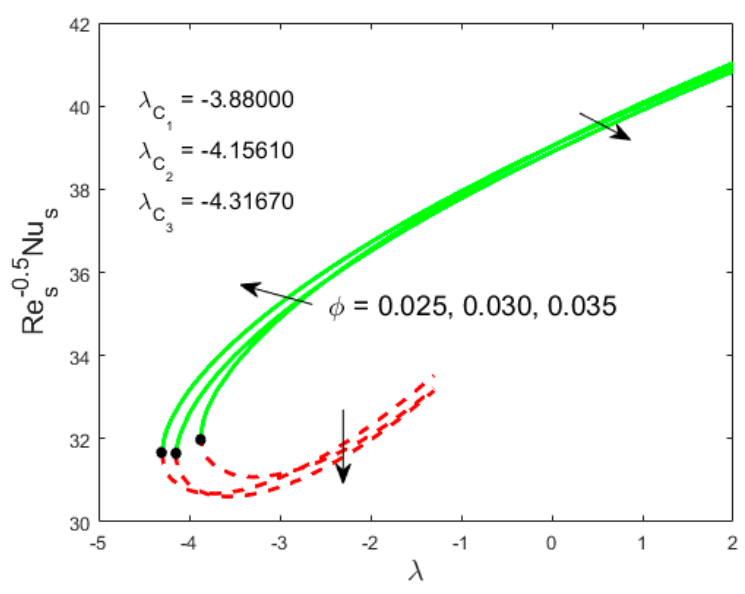
− 0.5 φ 0.5 λ Re Nu − versus λ . s Nu s versus on s s